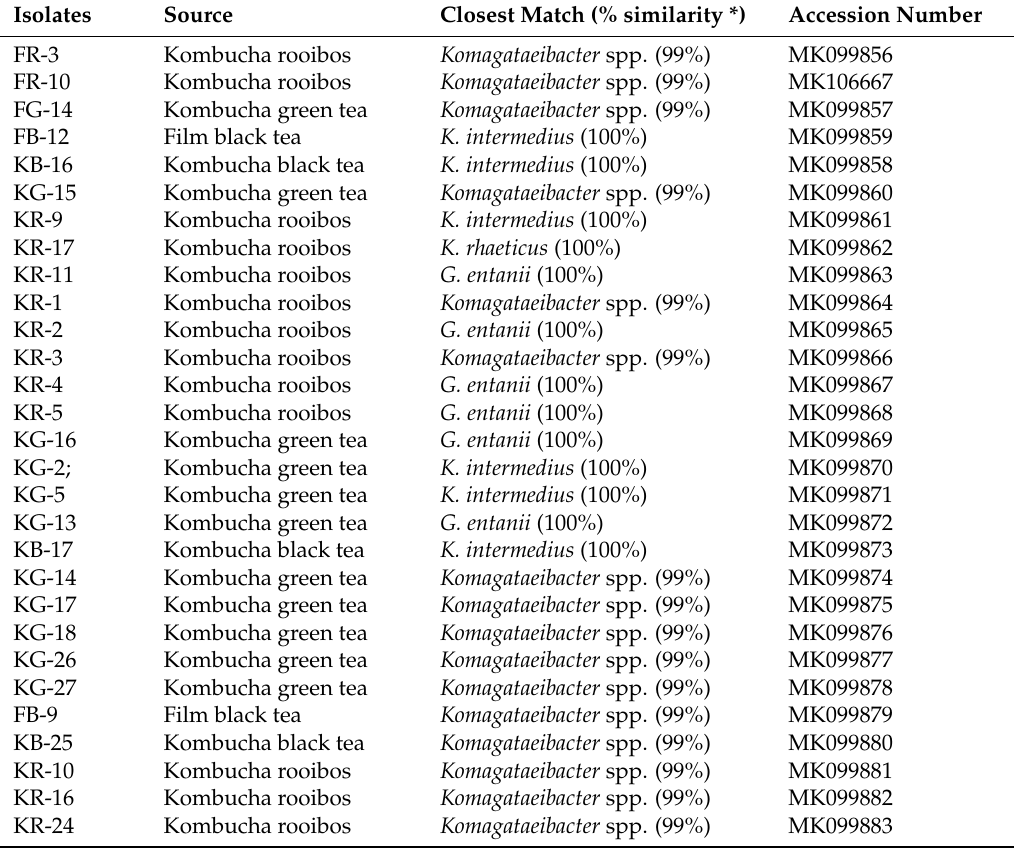
Table 1. Best-match identification of acetic acid bacteria (AAB) isolates from films and kombucha teas obtained by nBLAST.